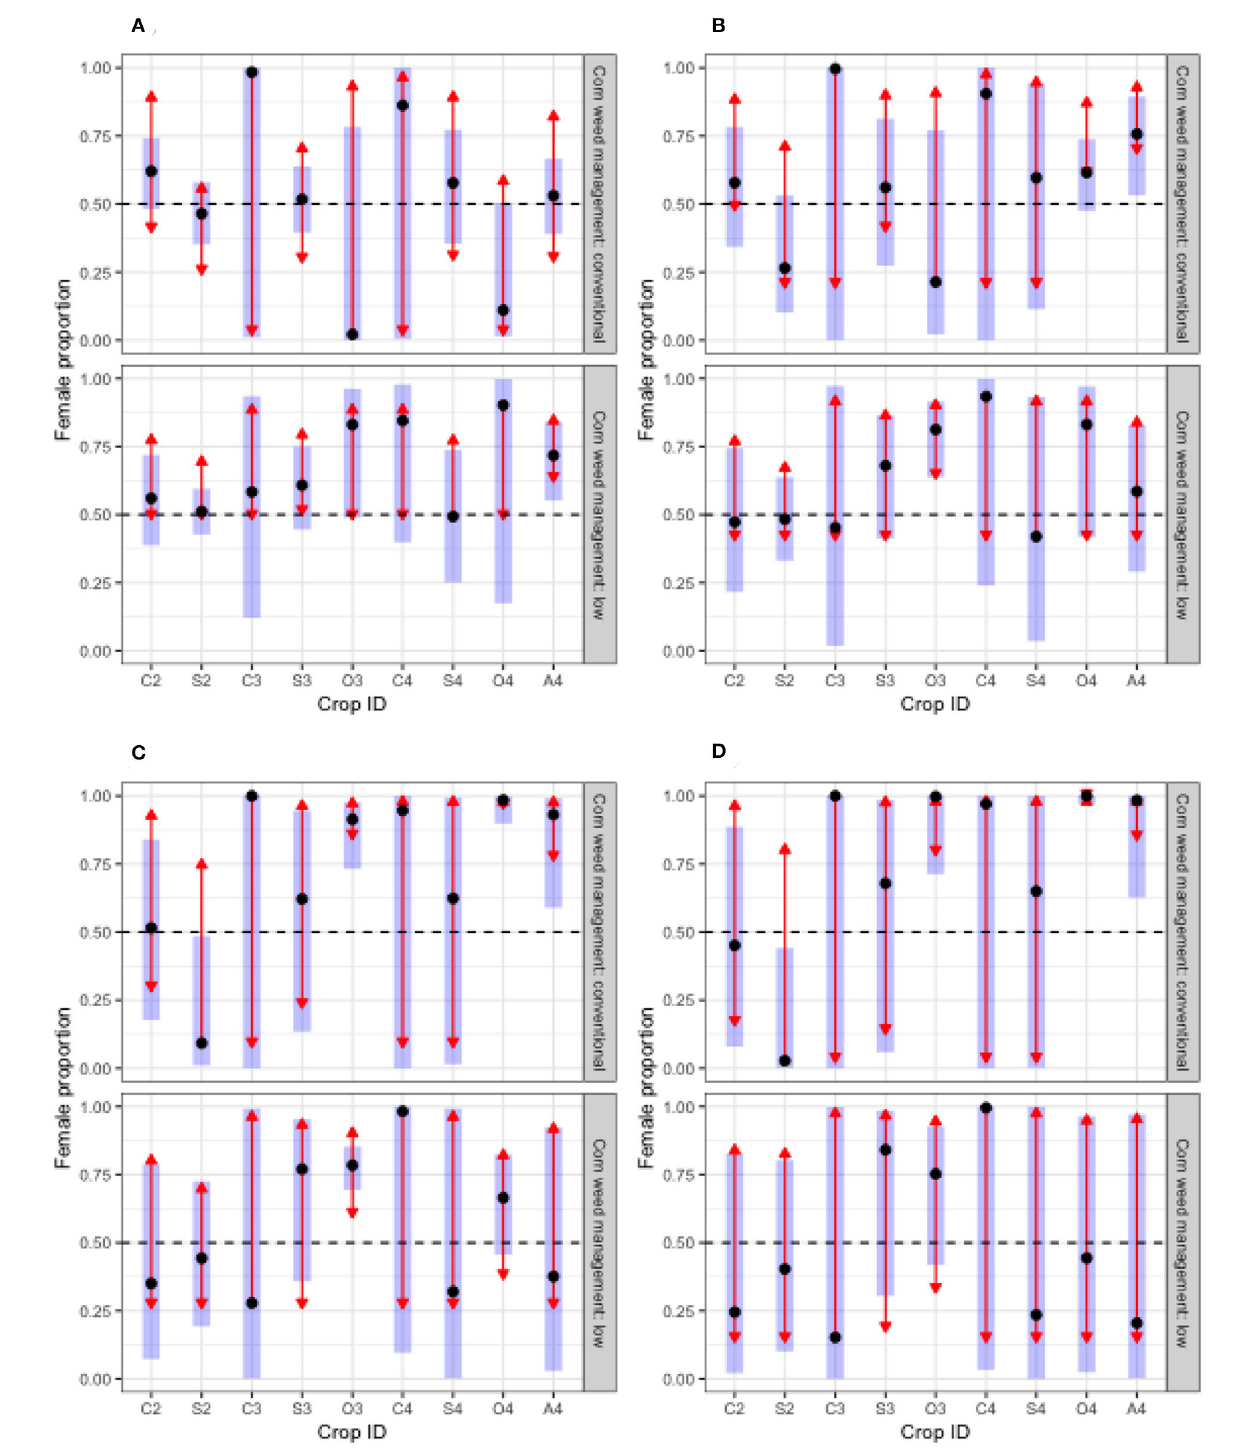
FIGURE 3 | Waterhemp population sex ratios under 54 combinations of experimental treatments and population stand densities. The abbreviations on the x -axis are crop identities, which are the combinations of the first letter in crop species names and the rotation to which the crops belonged (C2, corn in the 2-year rotation; C3, corn in the 3-year rotation; C4, corn in the 4-year rotation; S2, soybean in the 2-year rotation; S3, soybean in the 3-year rotation; S4, soybean in the 4-year rotation; O3, oat in the 3-year rotation; O4, oat in the 4-year rotation; and A4, alfalfa in the 4-year rotation). The dashed lines mark sex ratio parity. The black dots are estimated marginal means. The blue bars are 95% confidence intervals. The red arrows reflect the comparisons among means. Overlapping arrows indicate non-significant differences. (A) , 1 plants/m 2 ; (B) , 5 plants/m 2 ; (C) , 50 plants/m 2 ; (D) , 500 plants/m 2 .